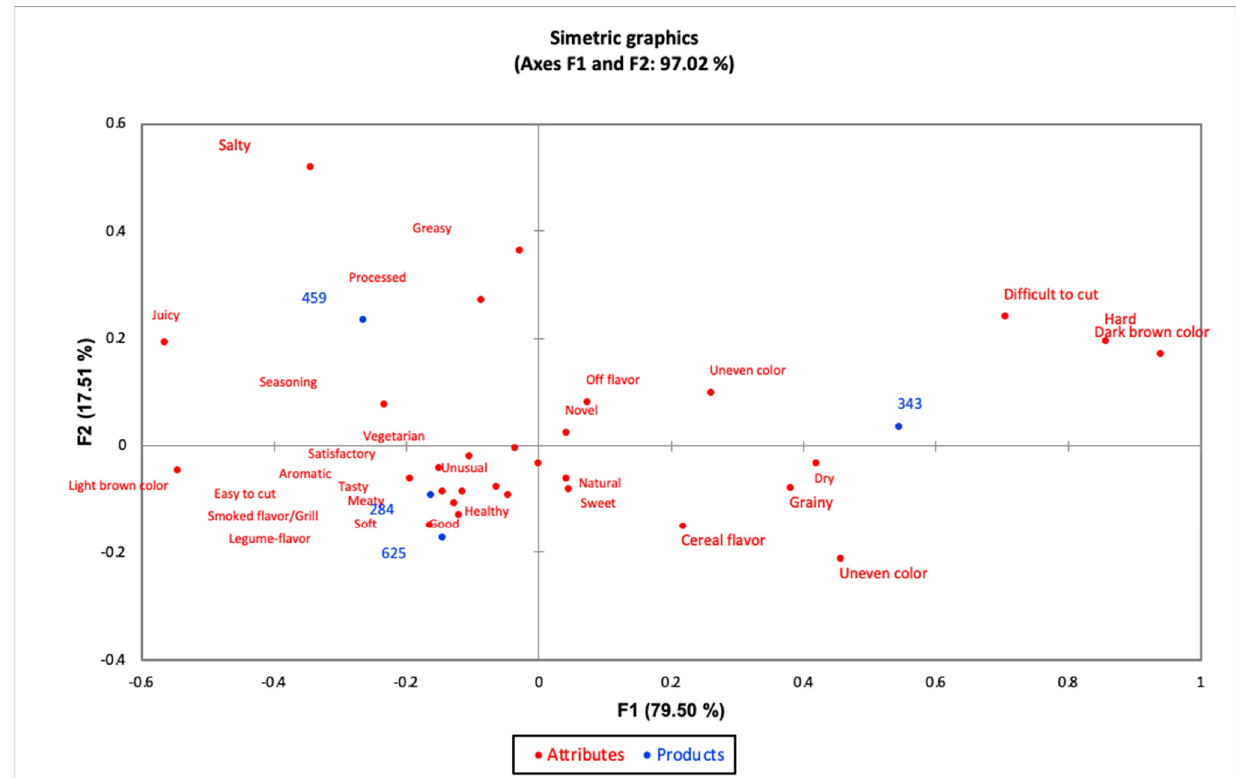
Figure 3. Correspondence analysis graph of hamburgers. 459 (33.33% quinoa, corn and lupine), 343 (commercial sample based on quinoa), 284 (90% quinoa and 10% lupine) and 625 (50% quinoa and 50% lupine).